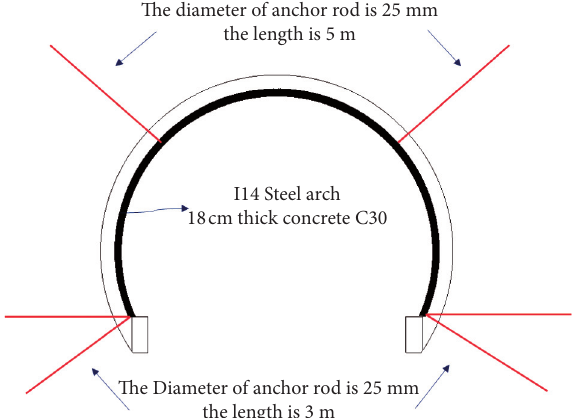
I14 Steel arch 18cm thick concrete C30